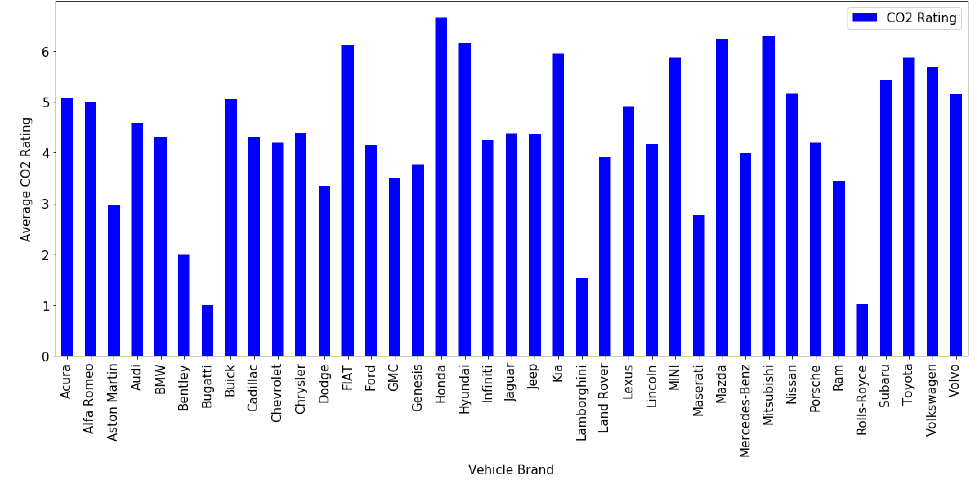
Figure 4. CO 2 rating of each brand.